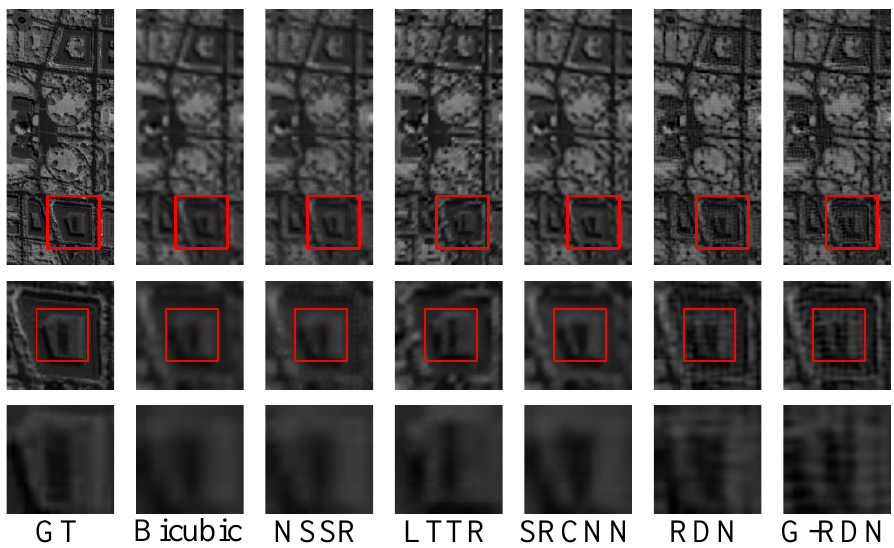
Figure 14. Visual exhibition of the reconstructed Washington DC Mall at the scaling factor of 3.